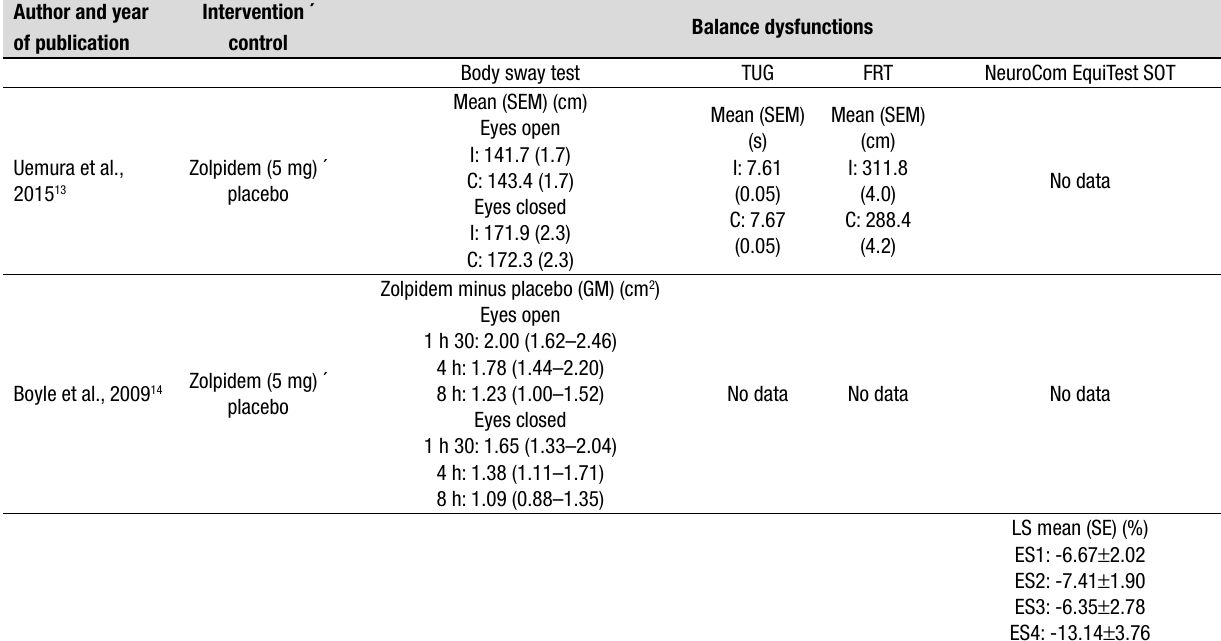
Table 4. Results: Balance